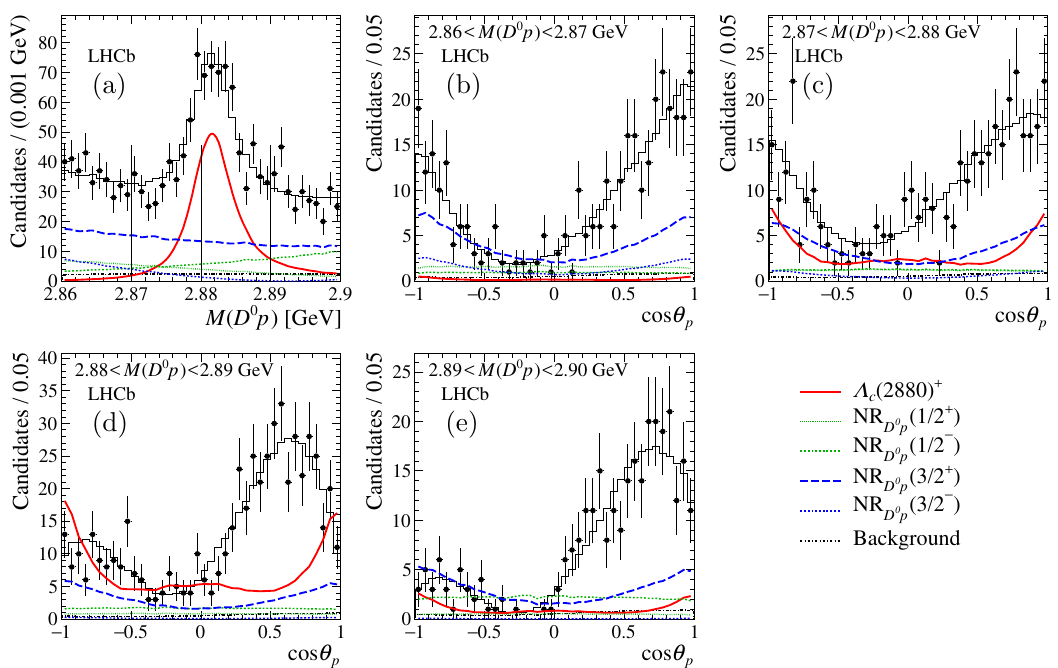
Figure 7 . Results of the (cid:3) 0 ! D 0 p(cid:25) (cid:0) amplitude (cid:12)t in the (cid:3) c (2880) + mass region with spin-parity b assignment J P = 5 = 2 + for the (cid:3) c (2880) + resonance: (a) M ( D 0 p ) projection and (b{e) cos (cid:18) p projections in slices of the D 0 p invariant mass. The linear nonresonant model is used. Points with error bars are data, the black histogram is the (cid:12)t result, coloured curves show the components of the (cid:12)t model. The dash-dotted line represents the background. Vertical lines in (a) indicate the boundaries of the D 0 p invariant mass slices. Due to interference e(cid:11)ects the total is not necessarily equal to the sum of the